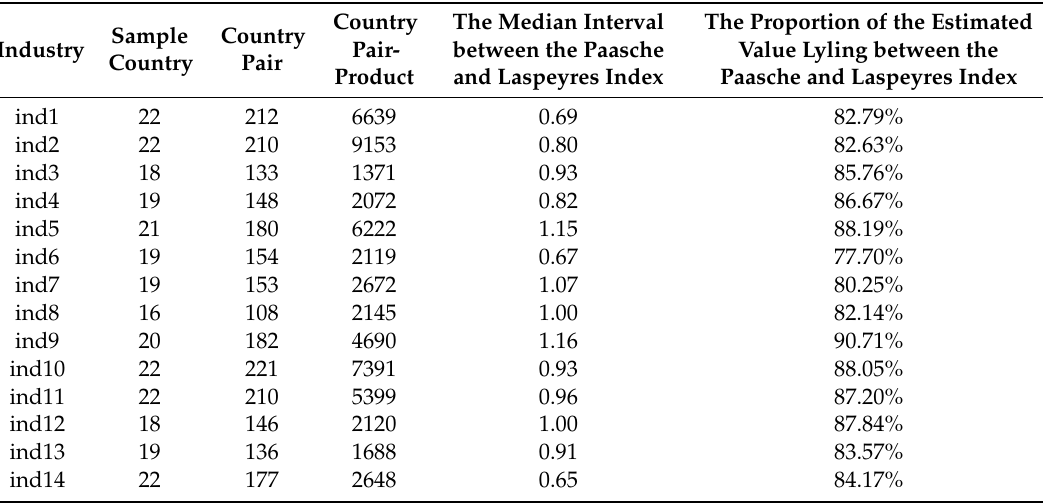
Table 2. The Estimation characteristics of